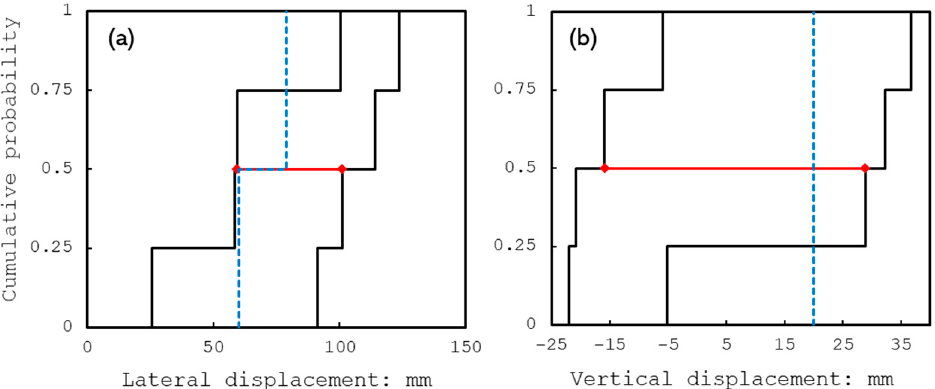
Figure 5. Serviceability limit state; post-construction ( a ) lateral displacements, ( b ) vertical